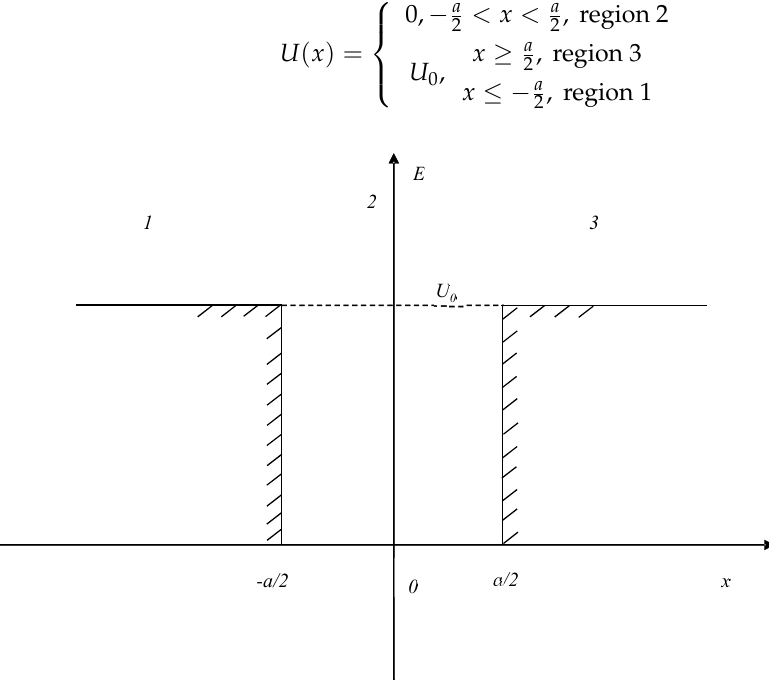
Figure 2. The most basic one-dimensional potential well with finite walls.